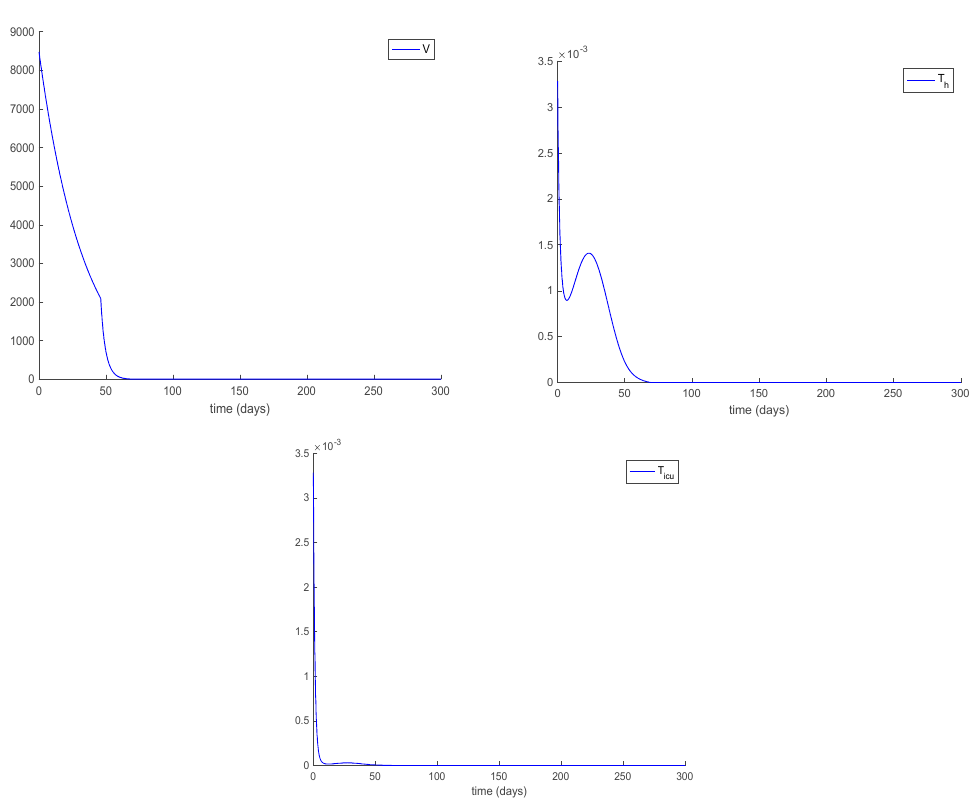
Figure 7. Control efforts when Programme 2 is employed and β is a control variable. Figure 7. Control e ff orts when Programme 2 is employed and β is a control